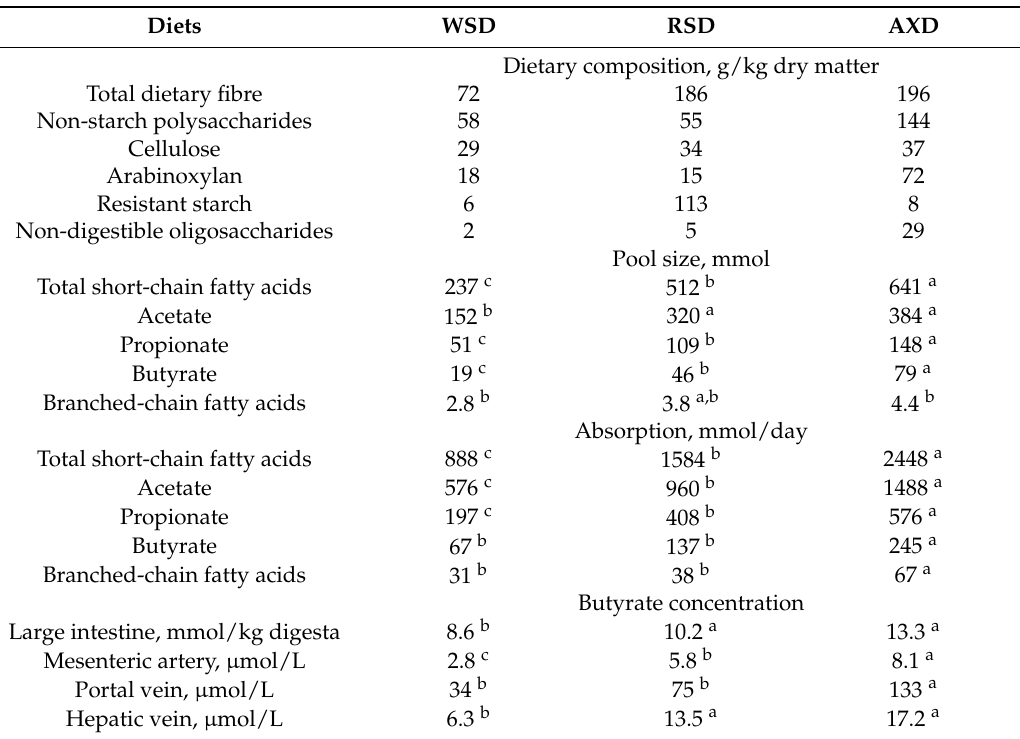
Table 1. Influence of diets varying in dietary fibre content and composition on short-chain fatty acids pool size in the large intestine and absorption of short chain fatty acids in intact and multi-catheterised pigs,